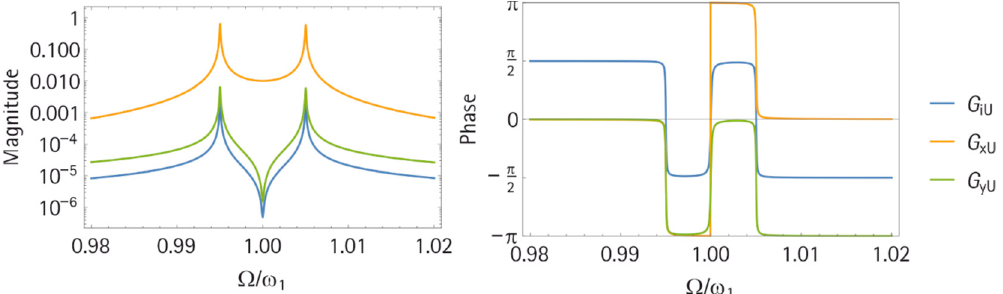
Figure 5. Frequency response for G iU , G yU , and G xU in magnitude (left) and phase (right). The used parameters were m = 1 kg, m n = 0, k = 10 N/m, M = 10 4 kg, k M = 10 5 N/m, D = d M = 5 × 10 − 4 Ns/m, C p = 10 nF, and α = 0.1